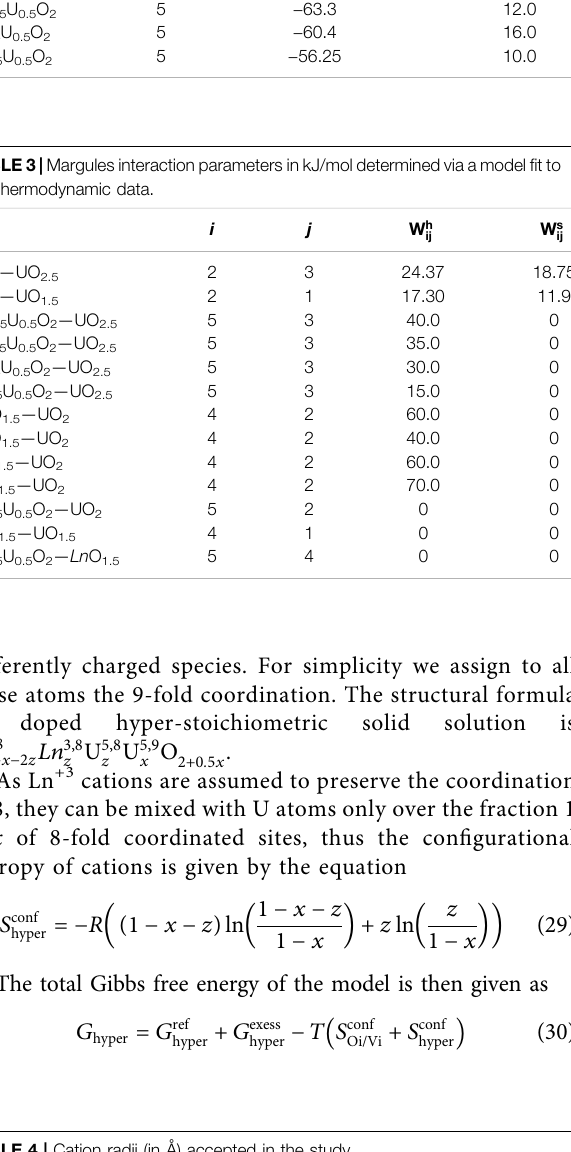
TABLE 4 | Cation radii (in Å) accepted in the study. C